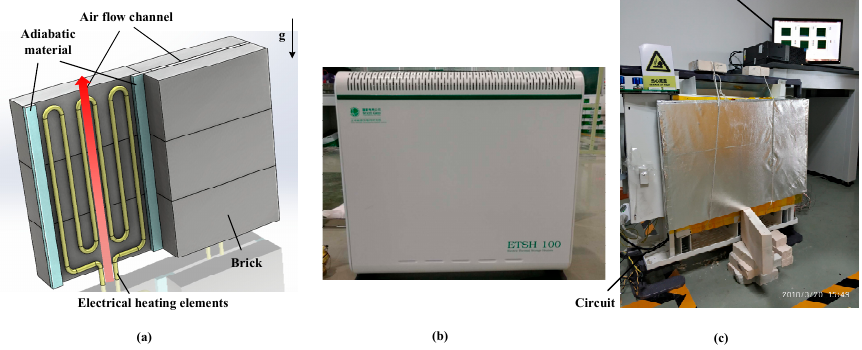
Figure 1. The proposed ETS device: ( a ) the inner structure, ( b ) the appearance with metal casing, ( c ) the configuration of the device being tested. Table 1. The thermal properties of the form-stable composite phase change brick.